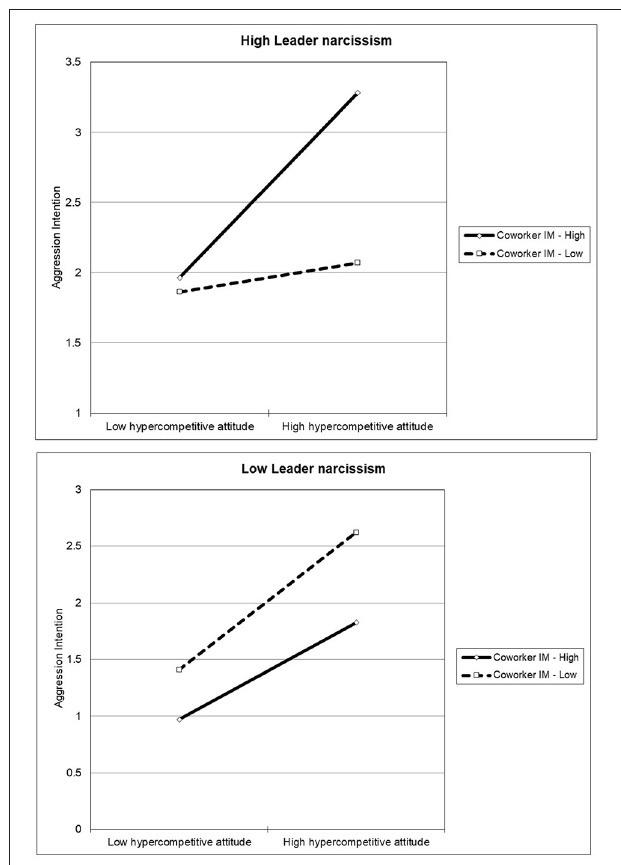
FIGURE 2 | The three-way interaction of hypercompetitive attitude, coworker IM, and leader narcissism on aggression